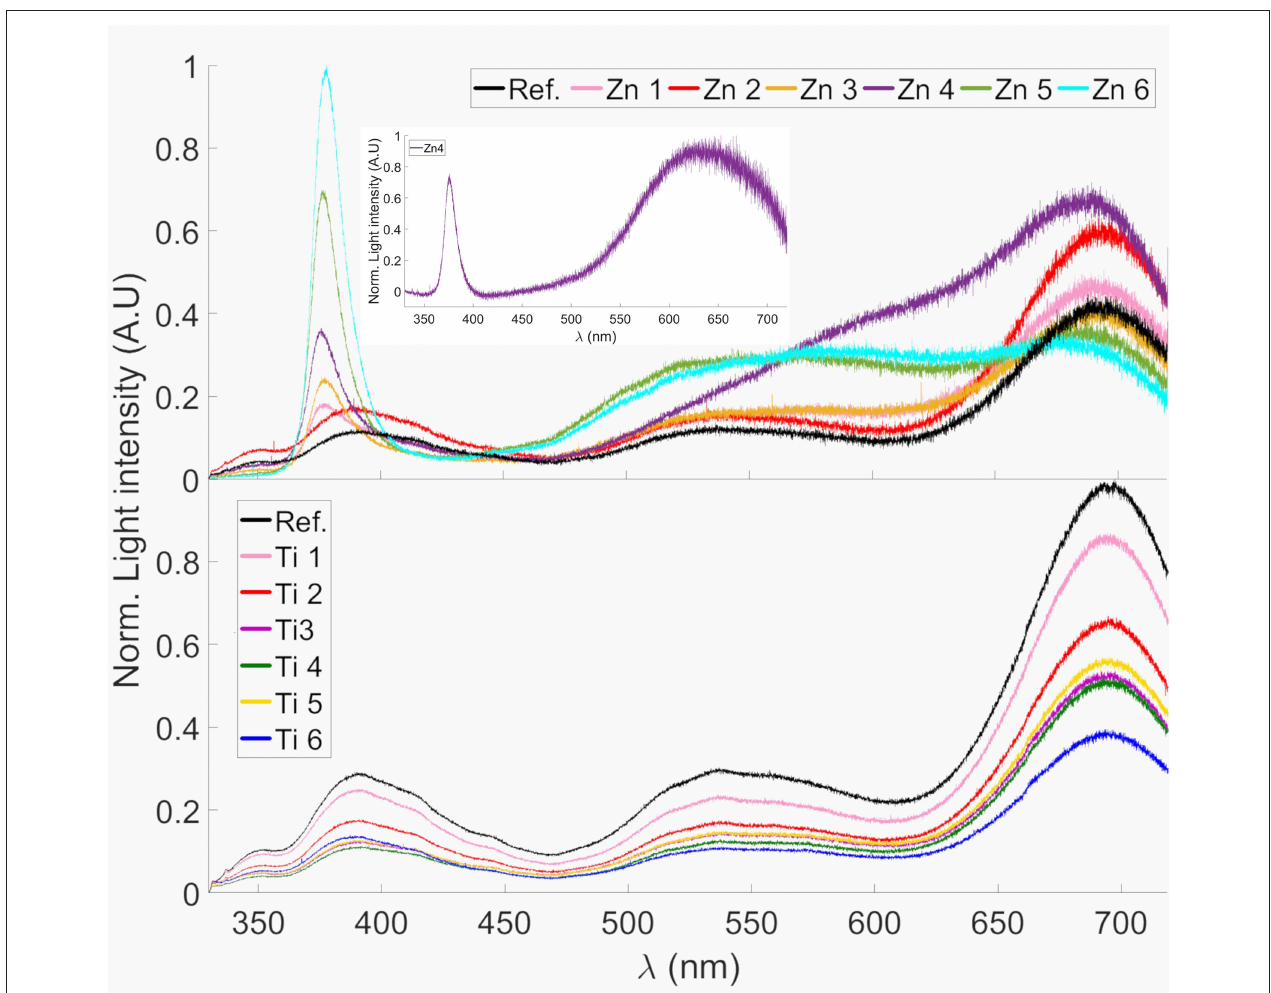
FIGURE 7 | Photoluminescence spectra of ZnO- and TiO 2 -coated glass samples. The spectra were normalized to the highest peak. The inset shows the Zn4 photoluminescence spectra subtracted by the reference, clearly revealing the 640nm emission